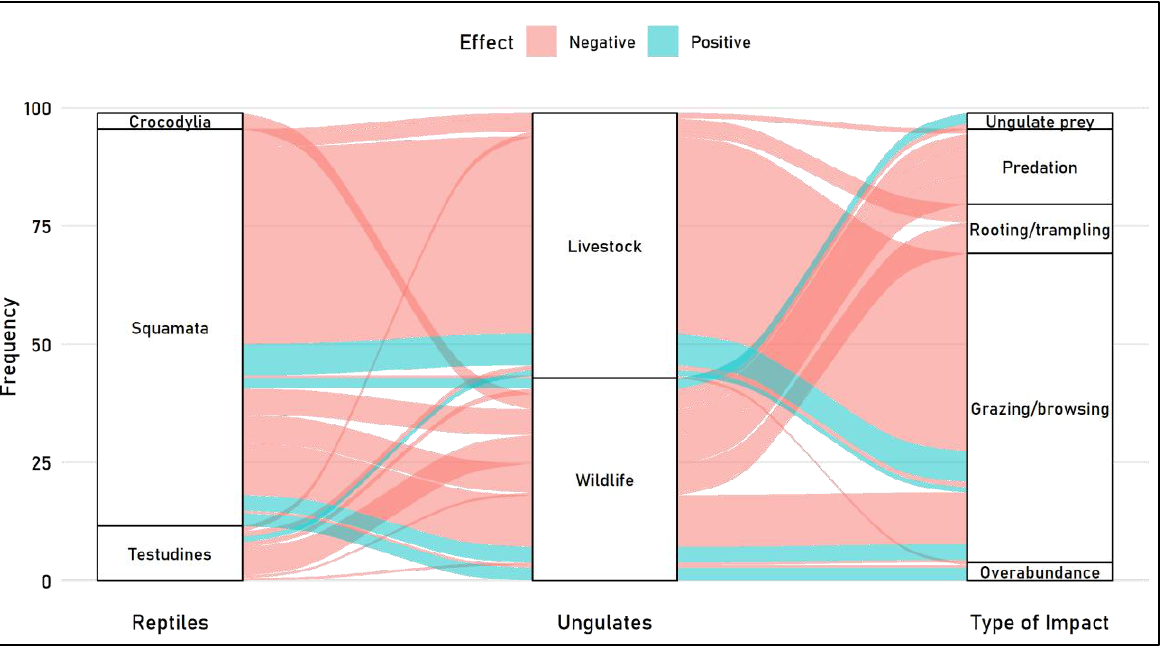
Figure 4. The distribution patterns (frequencies) of publications showing the different types of im- pacts / interactions of ungulates (wild ones and livestock separately) on / with different orders of rep-